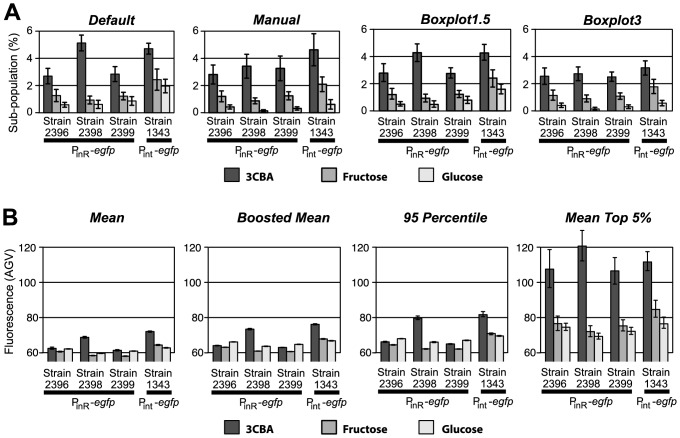
Different methods for quantification of subpopulation sizes of Pint-egfp or PinR-egfp expressing cells.(A) Output of four different PS methods for subpopulation size. For each method the same data set was used. (B) Same data as (A) but quantified via distribution-independent non-PS methods that do not determine subpopulation size. Error bars indicate the 95% confidence interval for re-sampled (bootstrapped) data. Dark grey bars: 3CBA grown cells; intermediate grey bars: fructose-grown cells; light grey bars: glucose-grown cells.